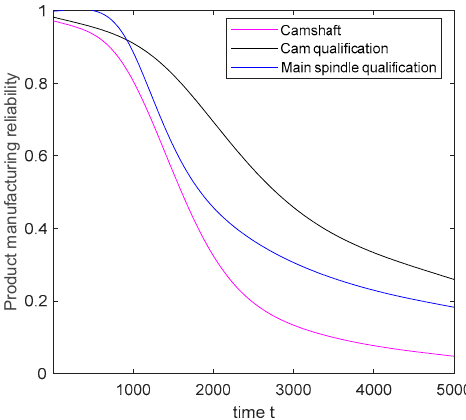
Figure 8. Probability of machines without failure of main spindle and cam.